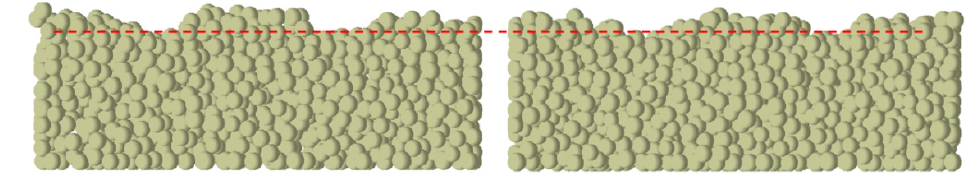
Figure 8. Amount of soil drop for two types of soil.